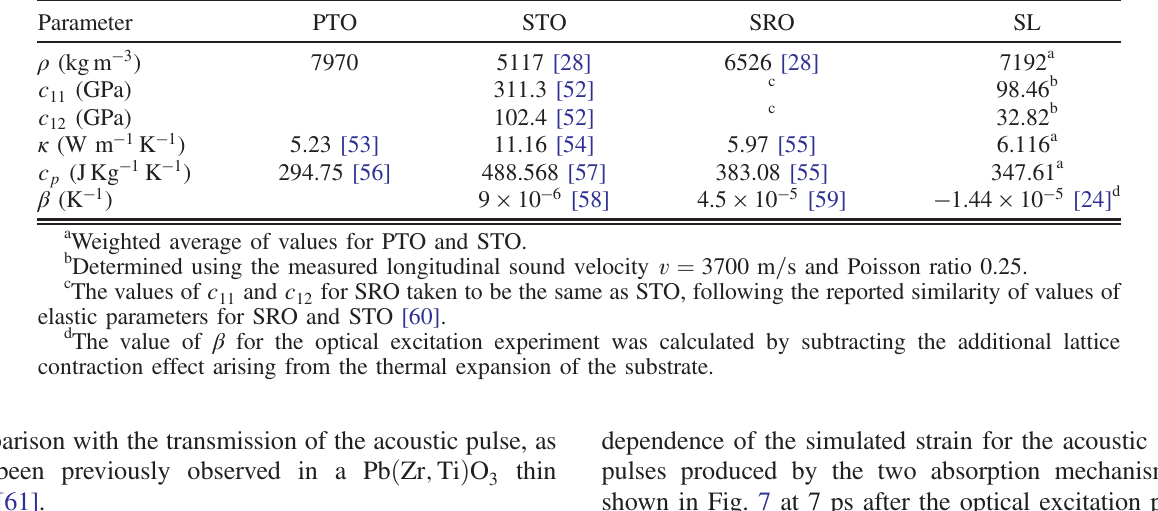
TABLE I. Parameters for the simulation of acoustic pulse propagation and heat transport. Parameter PTO